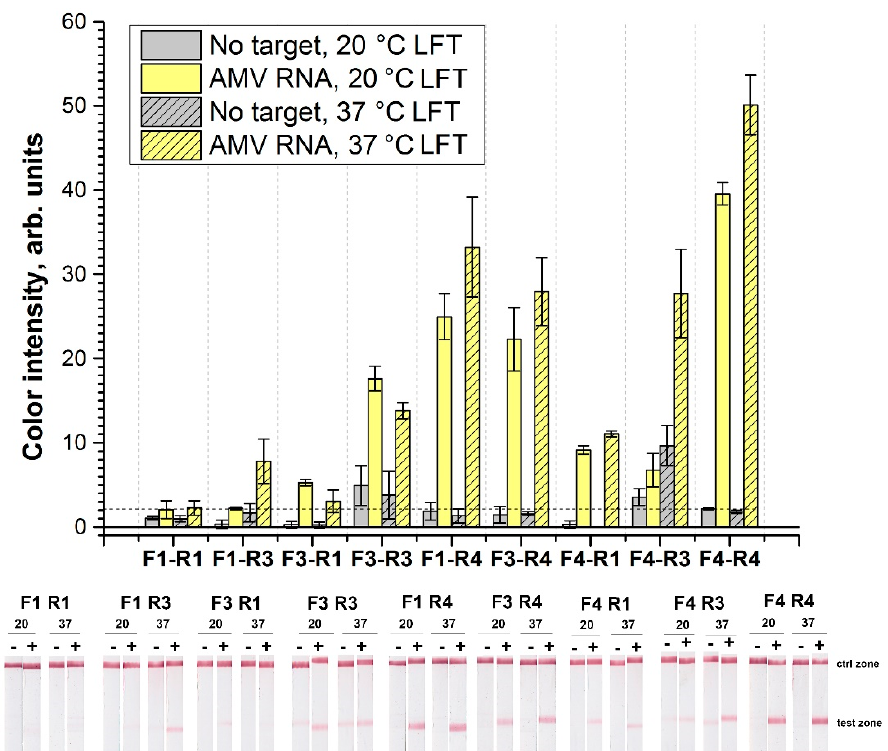
Figure 2. Signal in test zone of LFT strip after RPA of positive (10 7 copies of target) and negative (TE buffer) sample controls. LFT was performed at different temperatures. The dashed line represents a signal visible to the naked eye (2 a.u.).